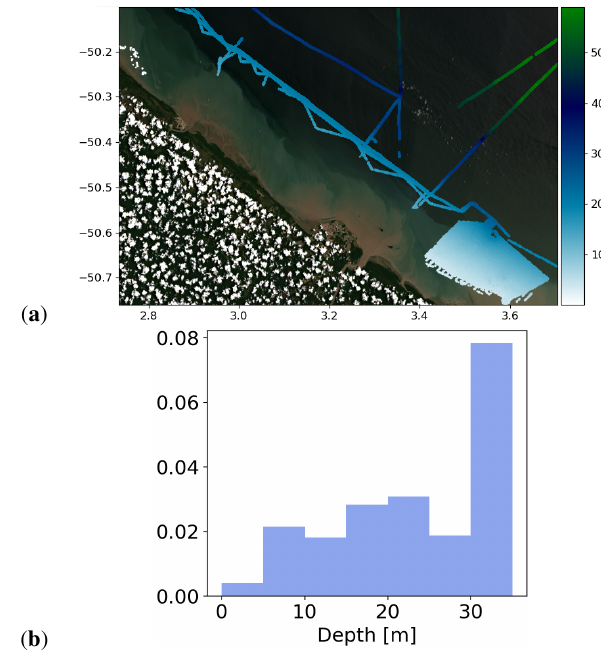
Figure 2. Water depth distribution of the bathymetry survey obtained for French Guiana from the French Naval Hydrographic and Oceanographic Service. ( a ) Spatial distribution of the survey used. ( b ) Distribution of depth points retained in the